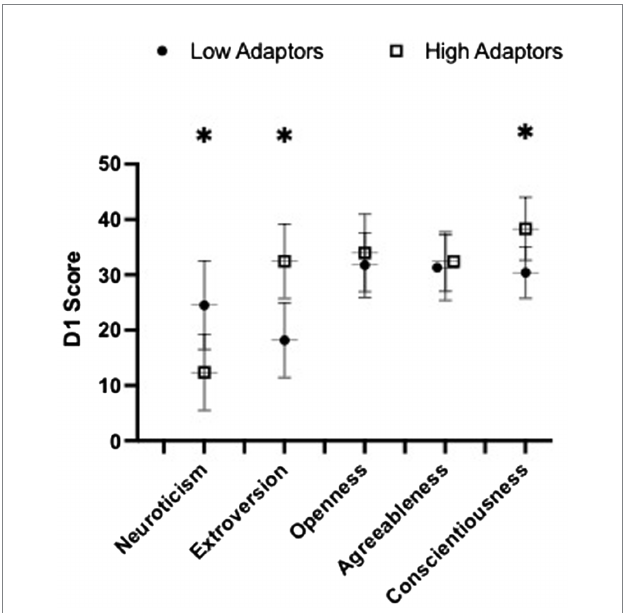
FIGURE 1 Baseline (D1) the NEO Personality Inventory Five Factor Inventory (NEO) personality scores stratified by low and high adaptive groups are presented here. Data presented as group mean ± SD. Significance was set at p < 0.05. 6 edges denotes significant group